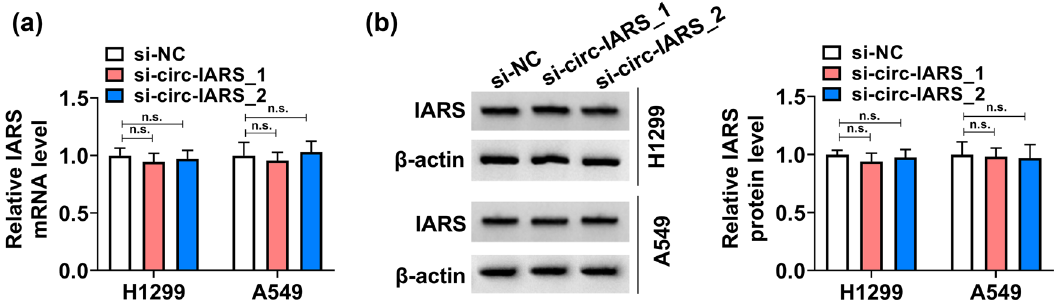
Figure A1: The e ff ects of si - circ - IARS_1 and si - circ - IARS_2 on IARS mRNA and protein expression were analyzed by RT - qPCR ( a ) and Western blotting ( b ) in H1299 and A549 cells. ns: no signi fi cant di ff